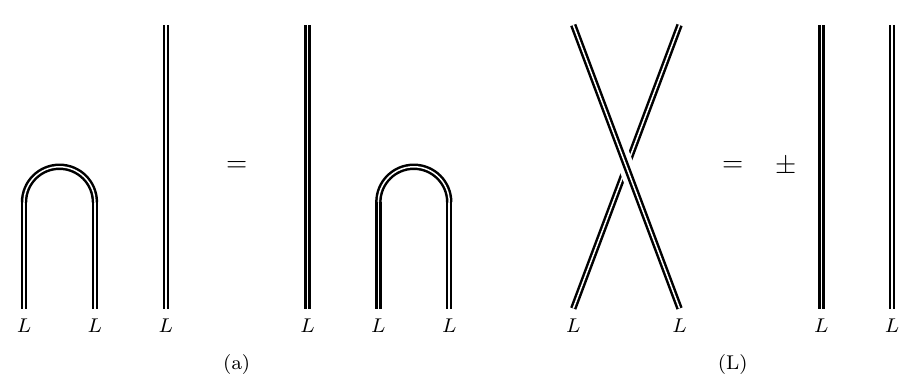
Figure 14 . Z 2 1-form symmetries: (a) There exists a bulk line L with properties shown in the (cid:12)gure. (b) Half-braiding L lines across each other gives a factor of (cid:6) 1 when compared to L lines without braiding. The factor of +1 arises for a bosonic 1-form symmetry generator L (cid:17) B and (cid:0) 1 arises for a fermionic 1-form symmetry generator L (cid:17) (cid:5). This minus sign implies that the symmetry is anomalous.